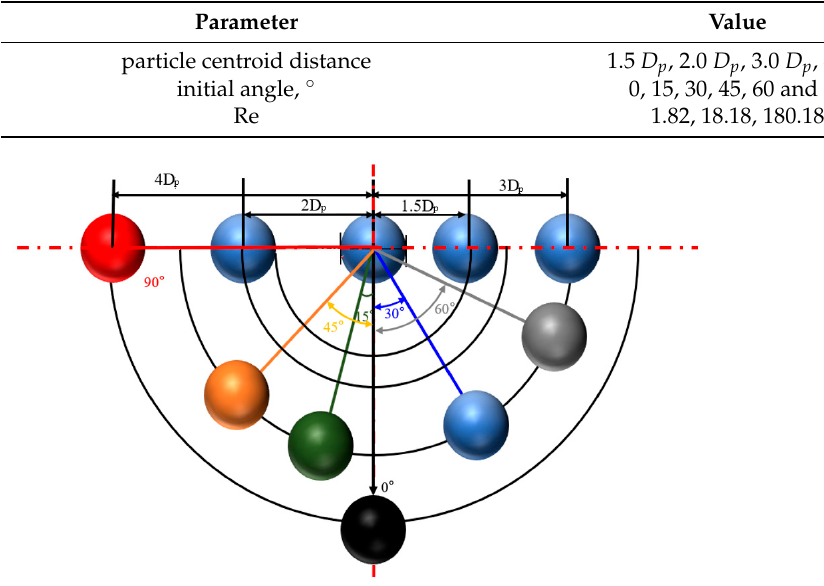
Figure 9. Diagram of relative positions studied.